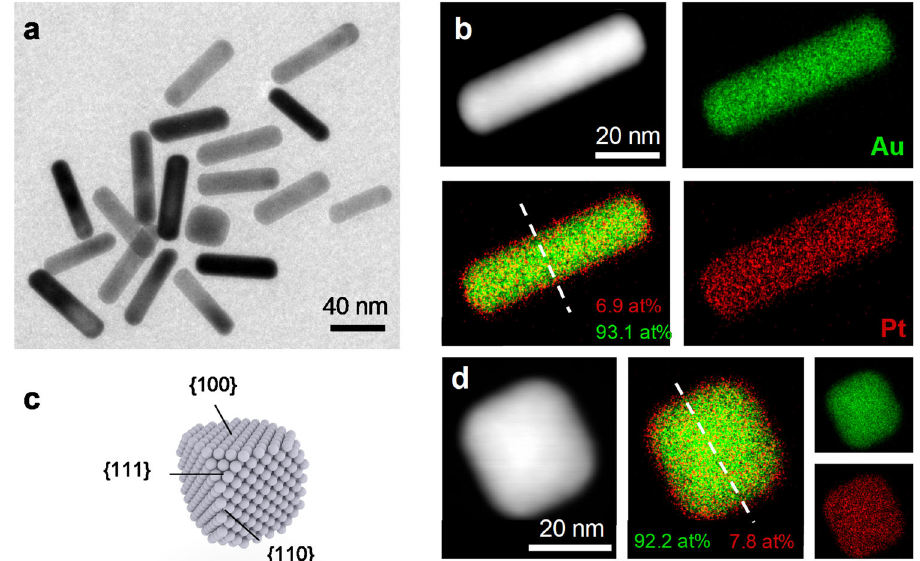
Fig. 4 Self-limited growth of a Pt-shell on shape-controlled nanoparticles. a TEM images of nanorods and nanocubes covered by a, in the subnanometer range lying Platinum shell. b , d HAADF images of a singular nanorod and nanocube and the respective Pt (red) and Au (green) elemental distribution. The respective crystal facets for cubic nanoparticles is displayed in c . The elemental line-scans can be found in Fig. S14 (white dotted